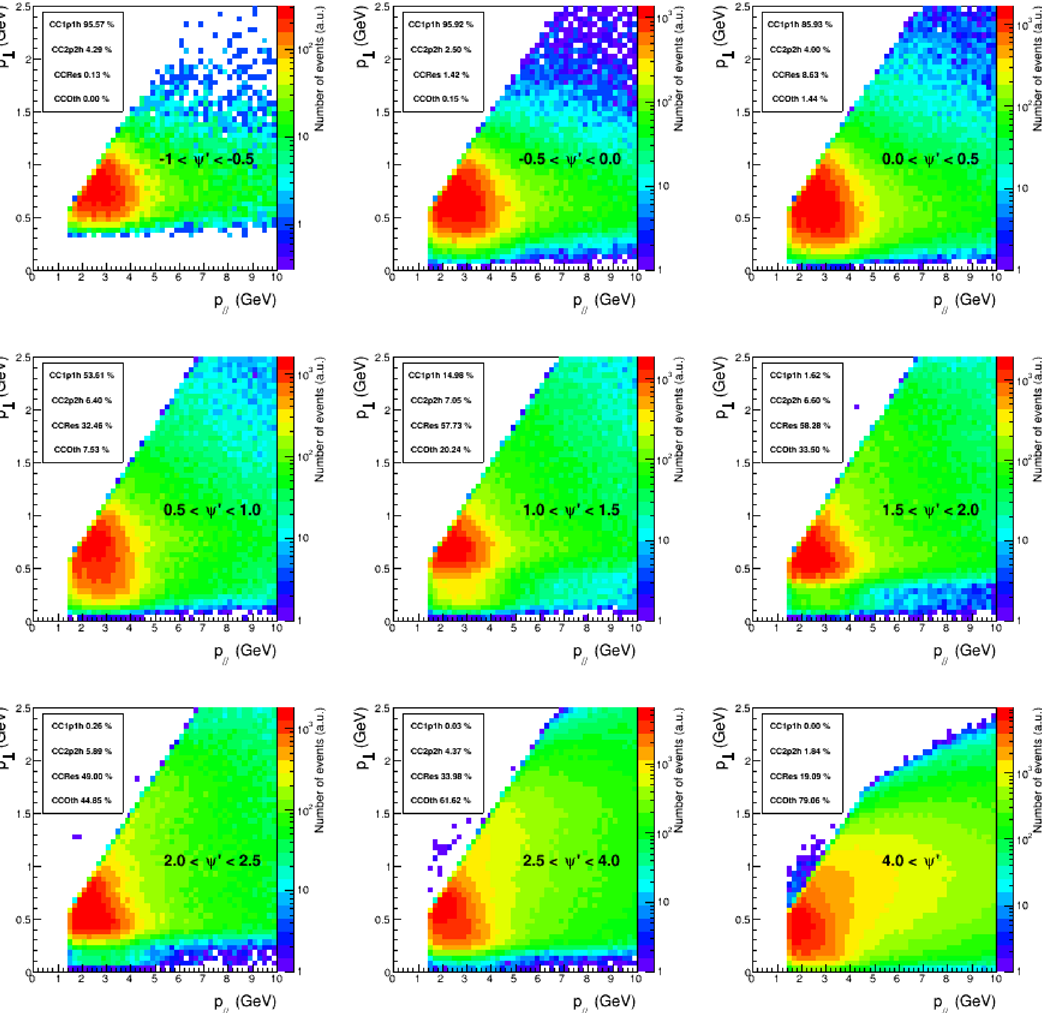
Figure 19 . Two dimensional ( p , p ⊥ ) lepton distributions accumulated for different ψ 0 -intervals k from the NEUT CC inclusive event generator for MINERvA flux. The contributions (in percentage) of the different interaction modes (CC1p1h, C2p2h, CCRes and CCOthers) are also shown in each of the